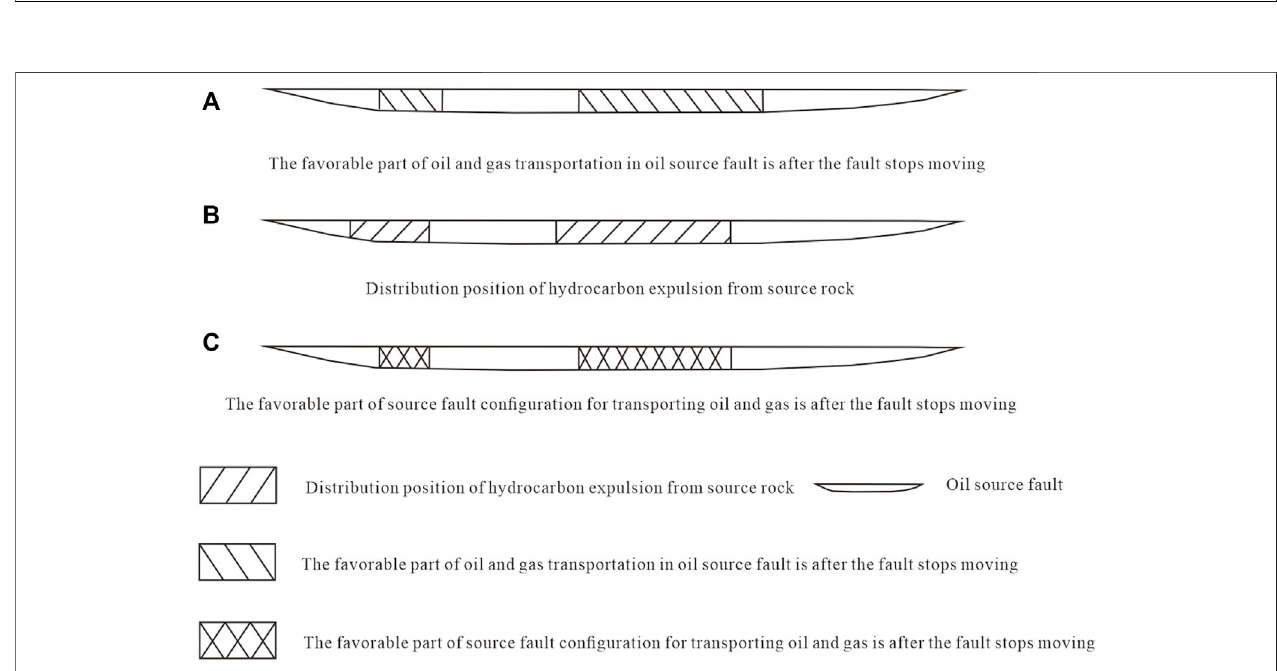
Frontiers in Earth Science |